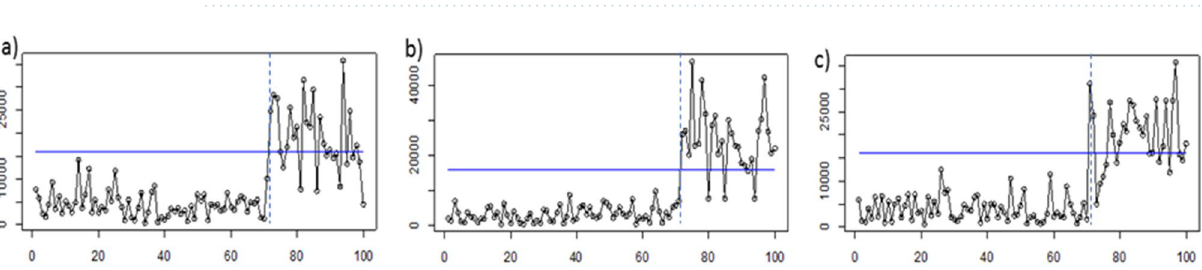
Figure 7. Application of the proposed Kernel PCA Mix chart with kernel RBF(0.001) for: ( a ) the first scenario, ( b ) the second scenario, and ( c ) the third scenario.